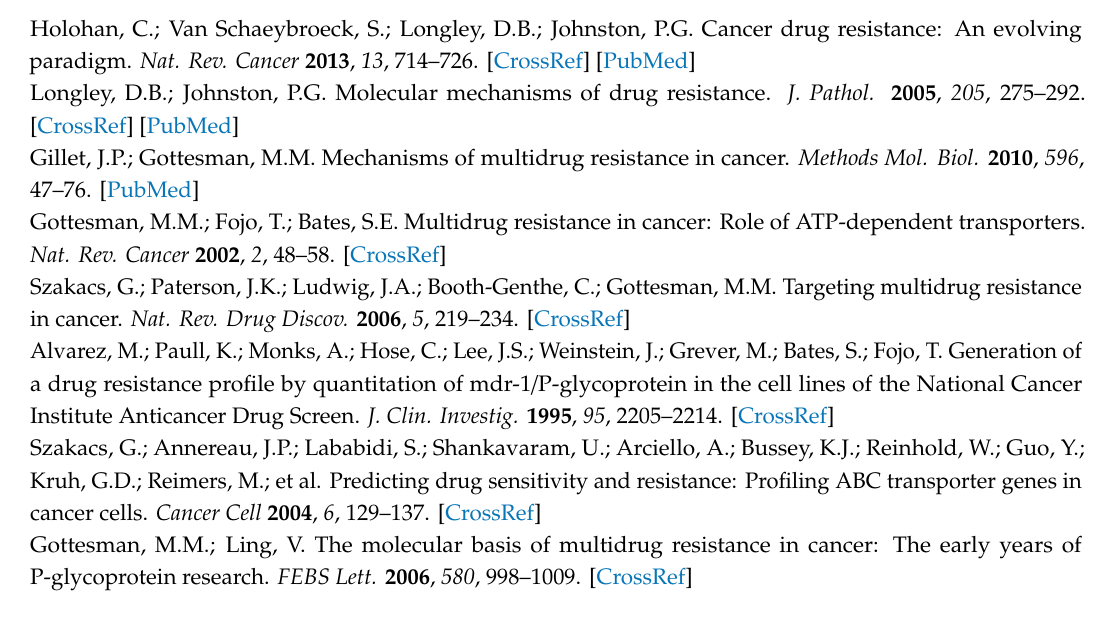
CA XII genes, Figure S2: Fluorescence curves obtained with a FACScanto flow cytometer, Table S1: Elution gradient of mobile phase used for LC–MS / MS analyses, Table S2: MRM parameters, Table S3: Linear regression data, linearity coe ffi cients, precision and LOD values for each